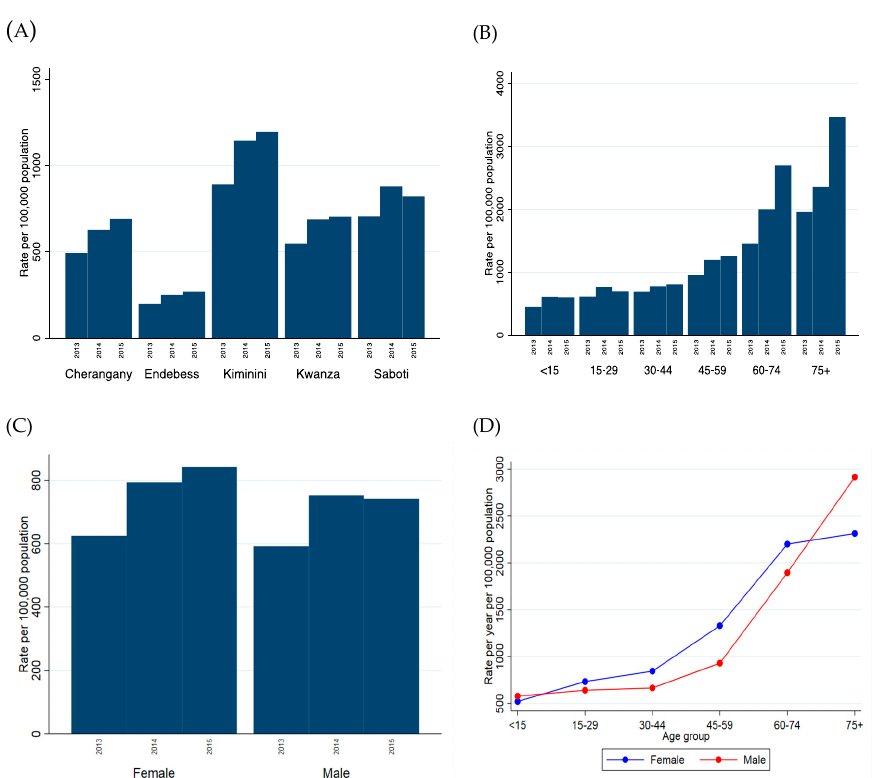
Figure 3. Attendance rates by ( A ) subcounty, ( B ) age group and ( C ) sex, across the three years. ( D ) shows the rate of attendance across age groups, stratified by age (attendance rate is the mean across the three years). Table 2. Attendance rates to Kitale eye unit for eye consultations, by year, subcounty, sex, and age in Trans Nzoia Kenya.